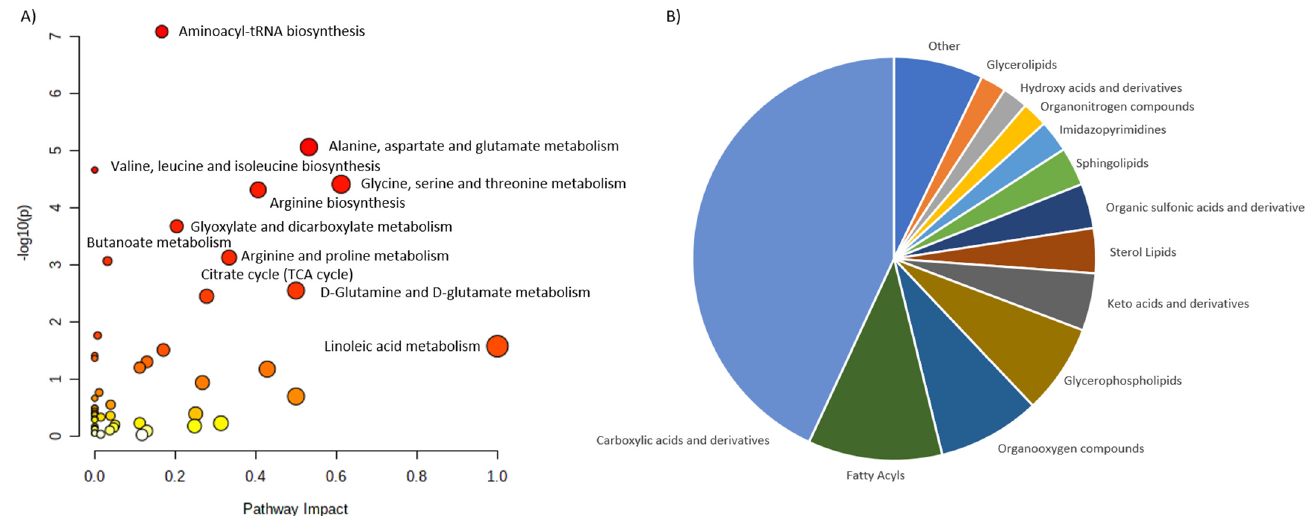
Figure 5. Characterization of metabolites altered in osteopenia and osteoporosis. ( A ) shows the main pathways, built for the discriminating metabolites reported in review publications. ( B ) shows pie chart, illustrating the distribution of the discriminating metabolites across different metabolite classes.